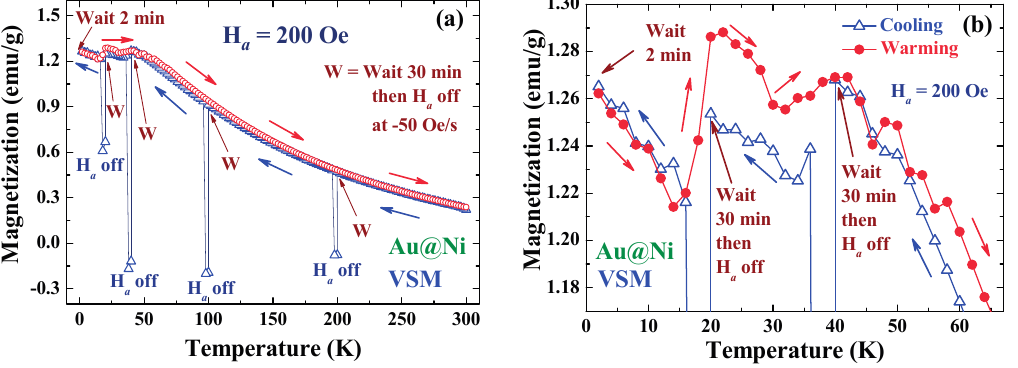
Figure 8. ( a ) Temperature dependencies of the magnetization collected at temperatures measured in steps of 2 K in the processes starting with cooling (open triangles) from 300 K with H a = 200 Oe. The W’s at 200, 100, 40 and 20 K mark the process of turning the H a off at a rate of R H = − 50 Oe/s for 3 min, after waiting for 30 min upon reaching that temperature. The arrows indicate the directions of the temperature-changing processes. The open circles indicate the magnetization measured in warming, after waiting for 2 min upon reaching 2 K. ( b ) Low temperature portions of the M(T) curves displayed in (a), showing step-like increases of M around 15 and 35 K, where H a has been turned off during cooling. No such behaviors are observed around 100 and 200